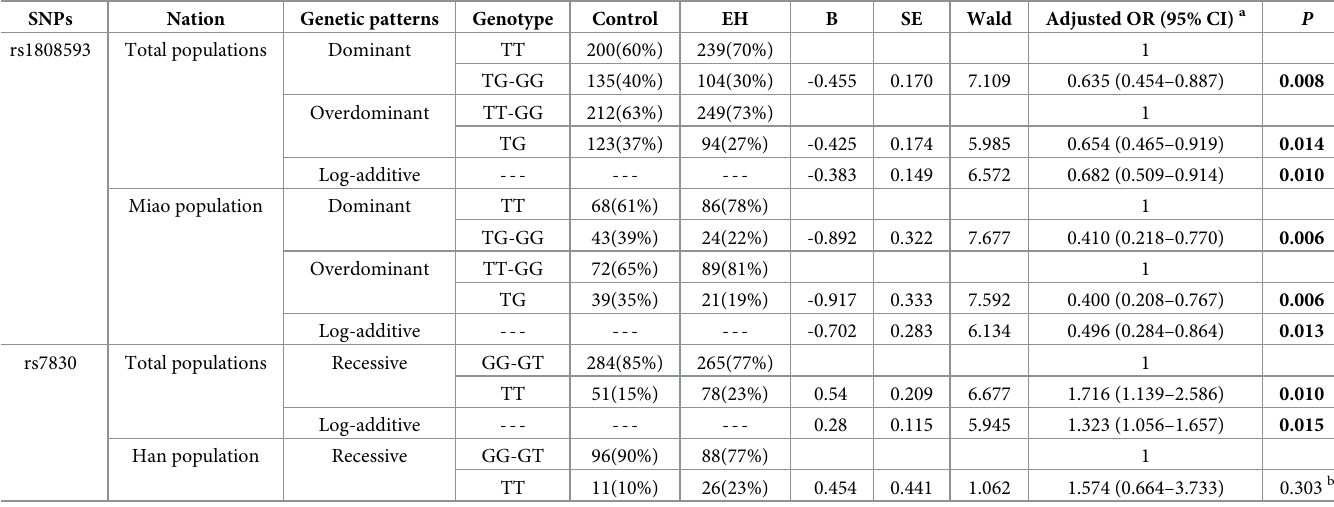
Table 4. Genetic patterns analysis of NOS3 gene in Guizhou